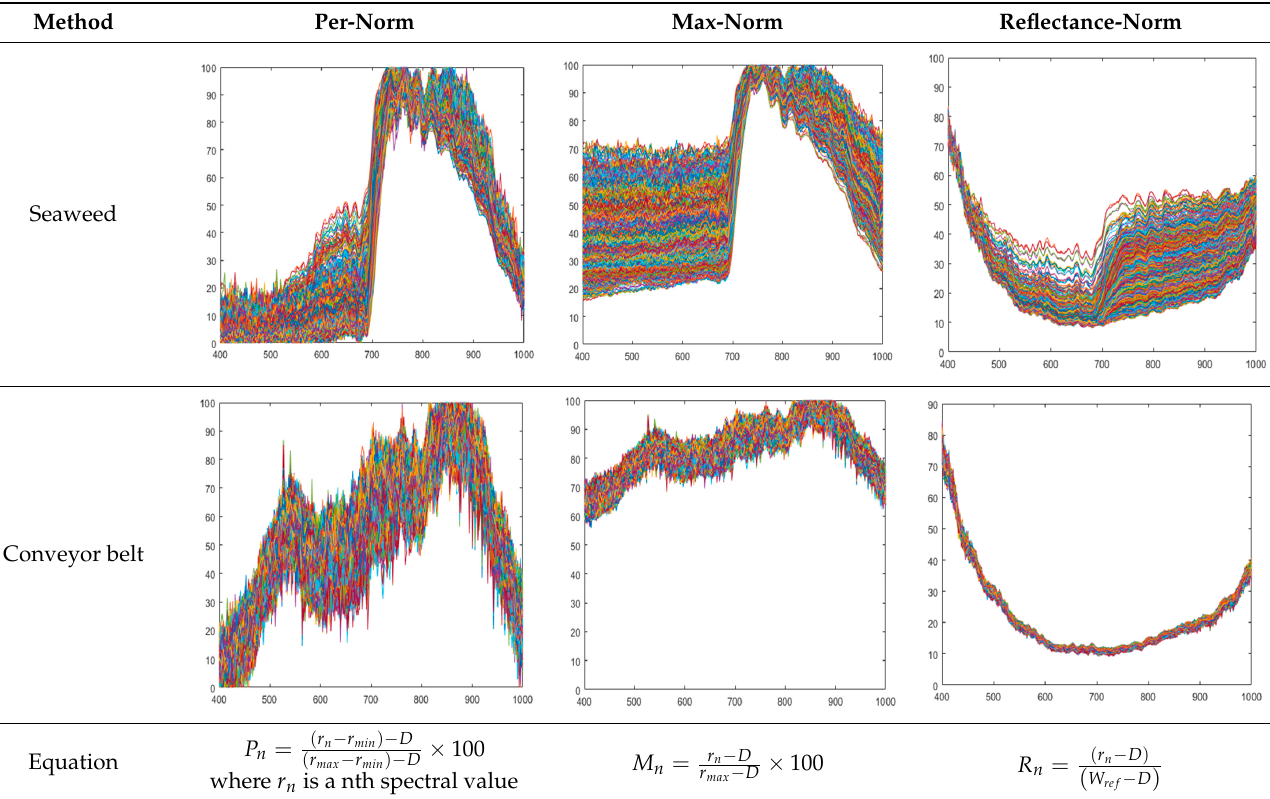
Table 3. Calibration results.